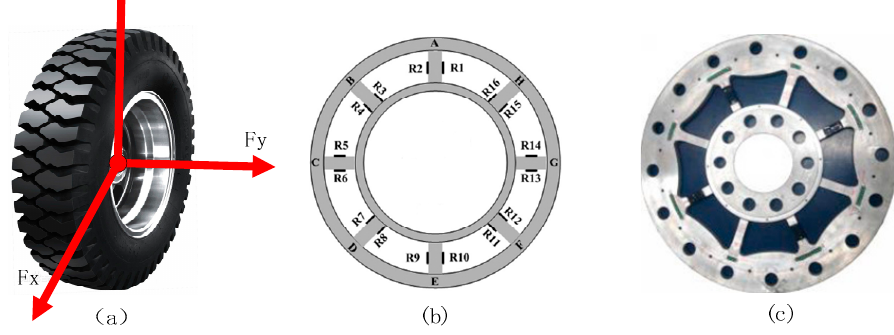
Figure 2. ( a ) Force diagram; ( b ) Diagram of the strain gauge arrangement; ( c ) Wheel force sensor.